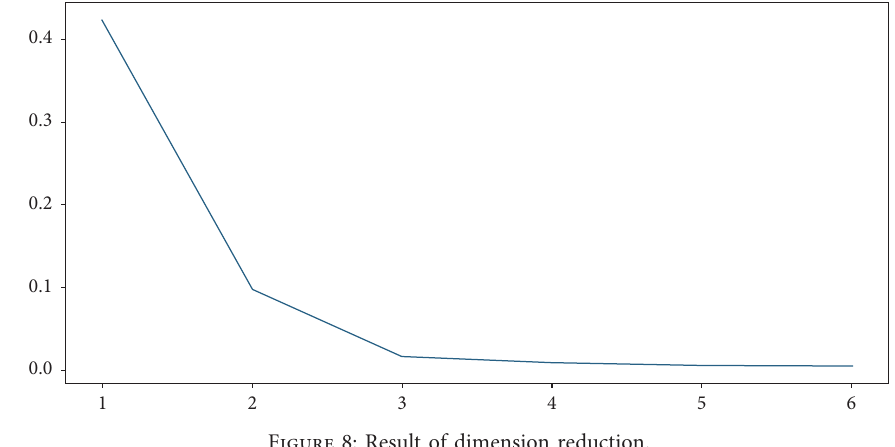
Figure 8: Result of dimension reduction.